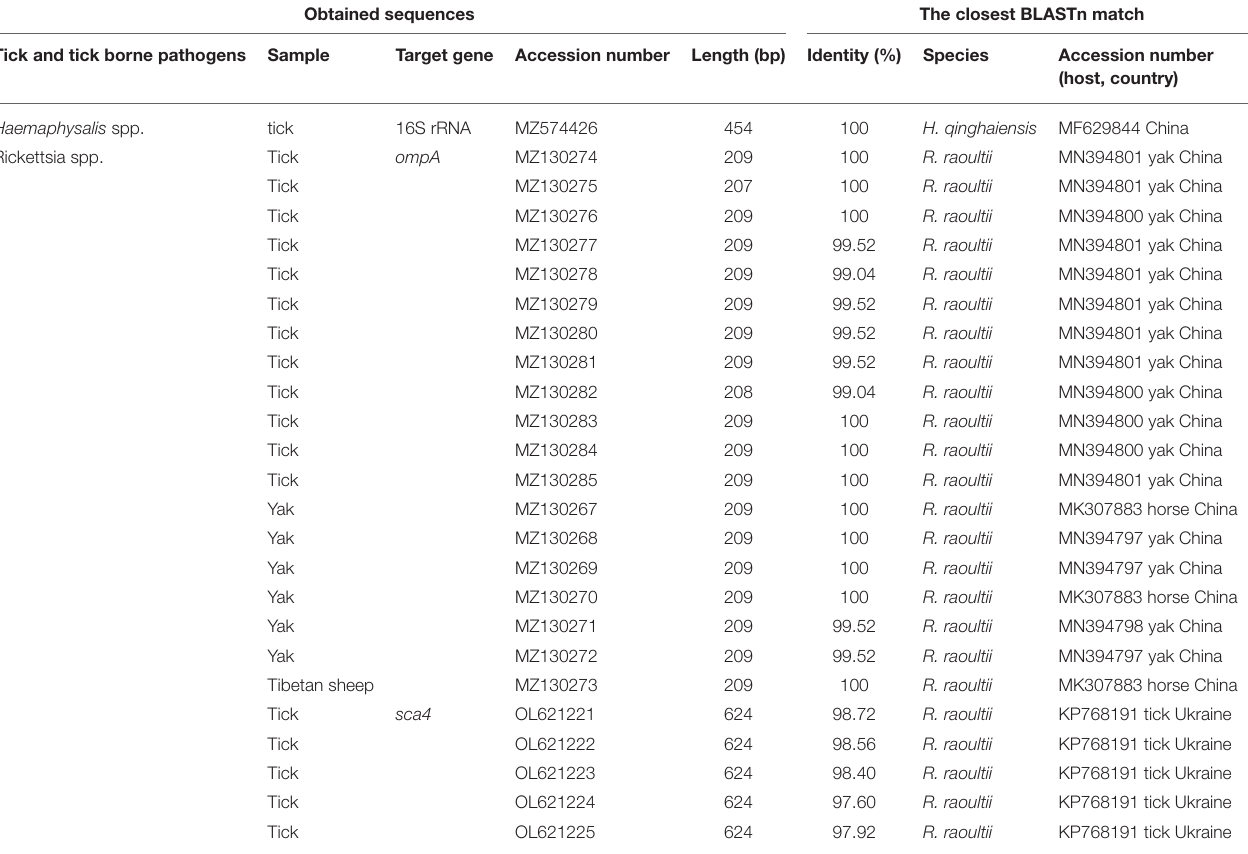
TABLE 1 | DNA sequences of spotted fever group (SFG) Rickettsia obtained in this study. Obtained sequences The closest BLASTn match Tick and tick borne pathogens Sample Target gene Accession number Length (bp) Identity (%)